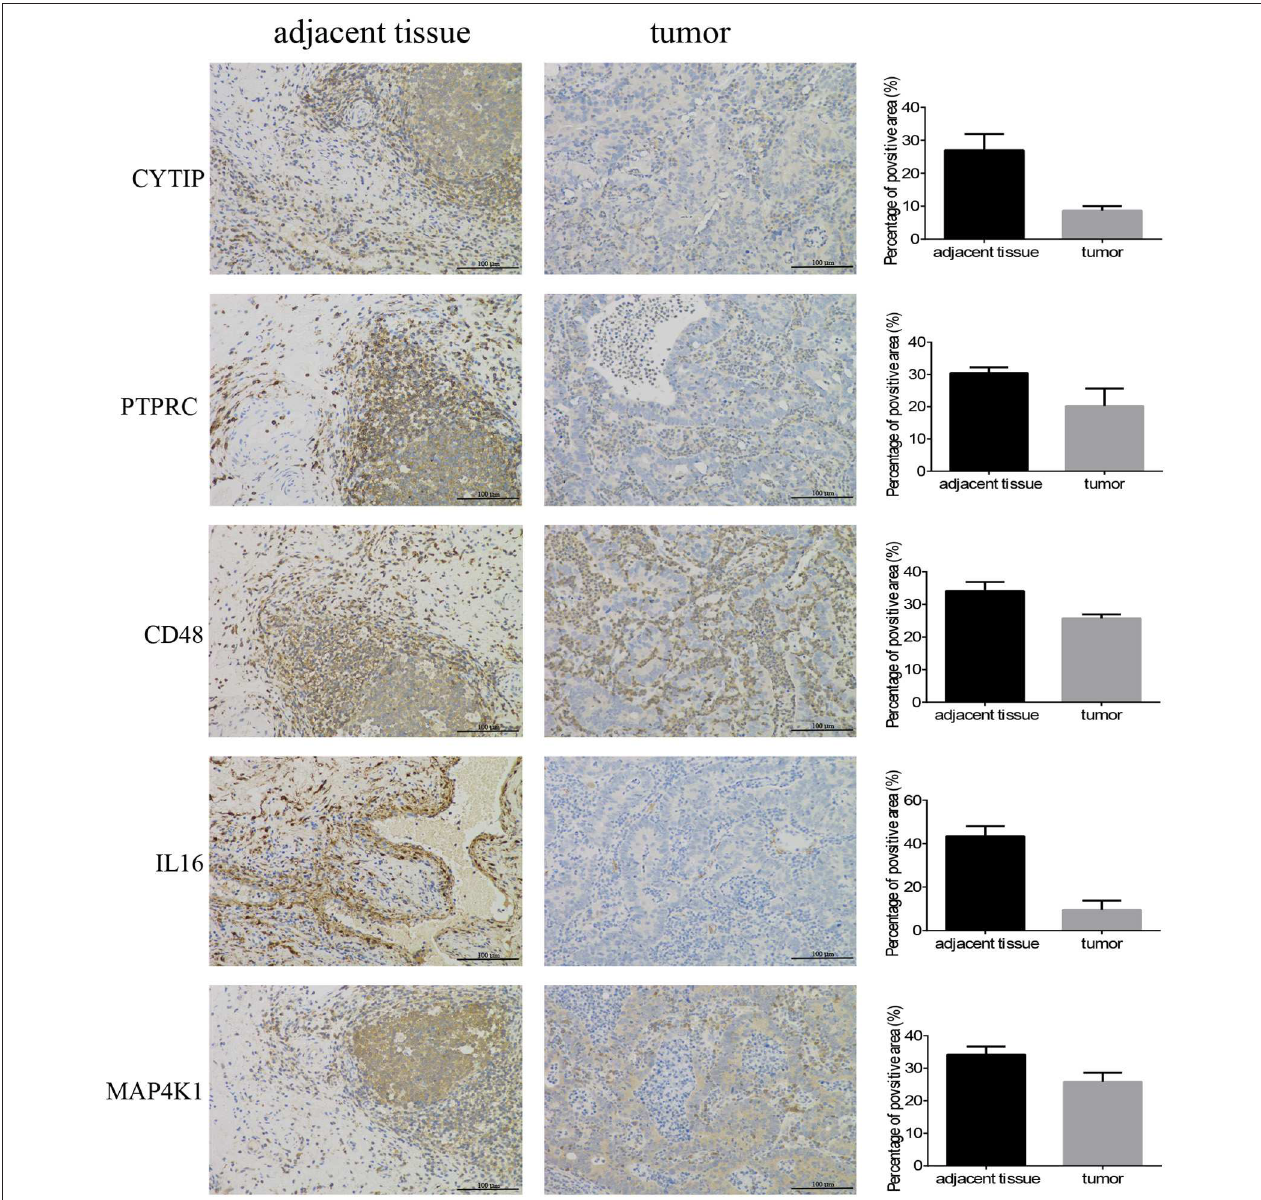
FIGURE 5 | Immunohistochemistry. Five hub genes expression in 12 pairs of bladder cancer and adjacent tissues (magnification 200 ×